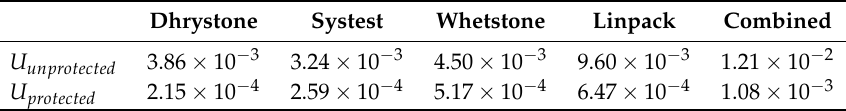
Table 8. Errors per second of the unprotected and DTMR-protected